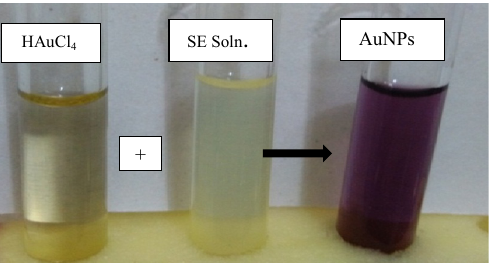
Figure 1: Synthesis of AuNPs through green approach using HAuCl 4 as a source of Au 3 + and SE as the reducing and stabilizing